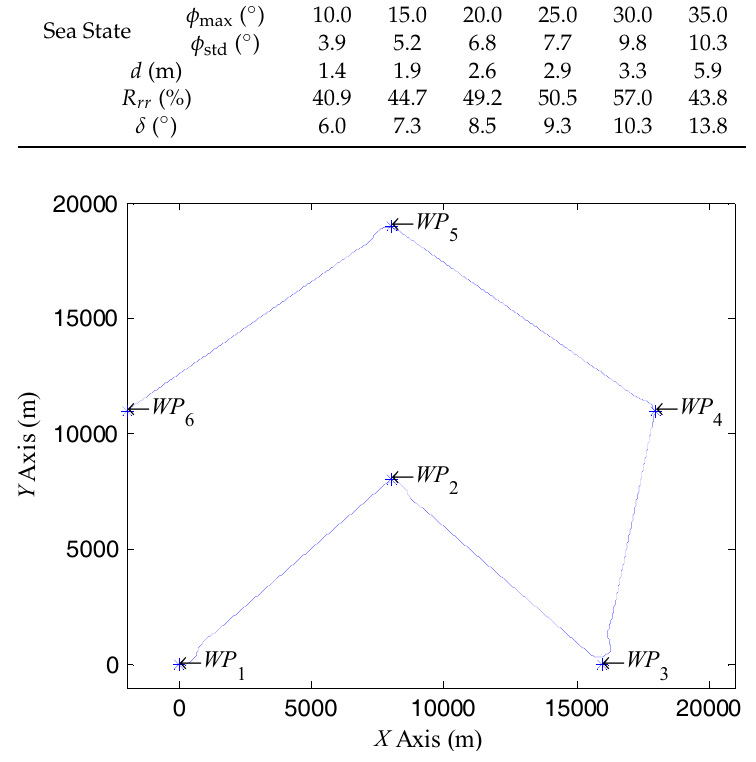
Figure 8. The path following results in X - Y plane.